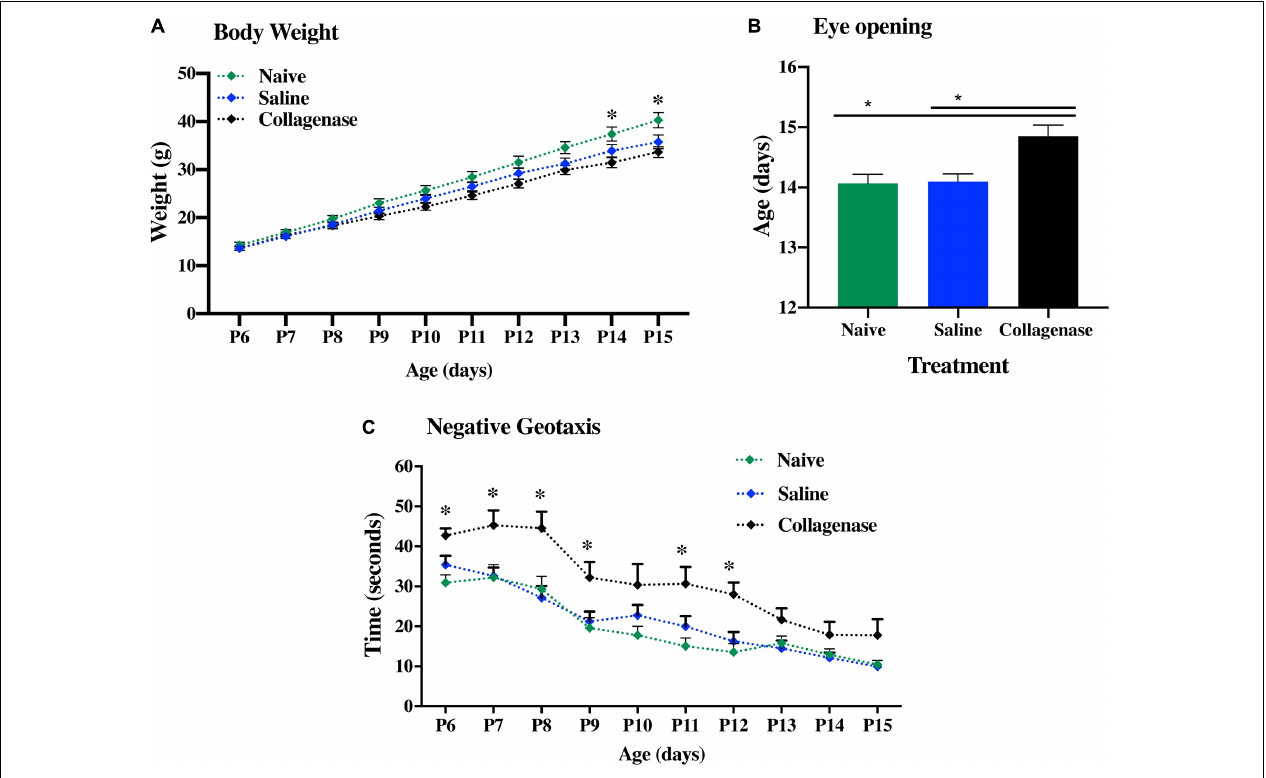
FIGURE 4 | Neurodevelopmental deficits following GMH. (A) Weight gain over time, (B) Latency in eye opening, and (C) negative geotaxis assessment of naïve ( n = 10), saline ( n = 10), and 0.3 U collagenase ( n = 12) animals. Data represented as mean ± SEM and analyzed using Kruskal-Wallis Dunn’s test. ∗ P < 0.05–0.001.